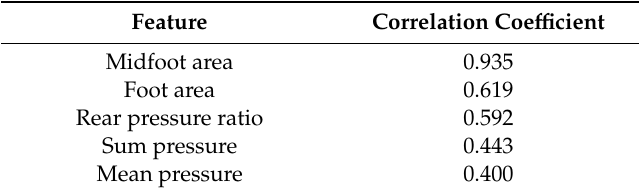
Table 2. Selected